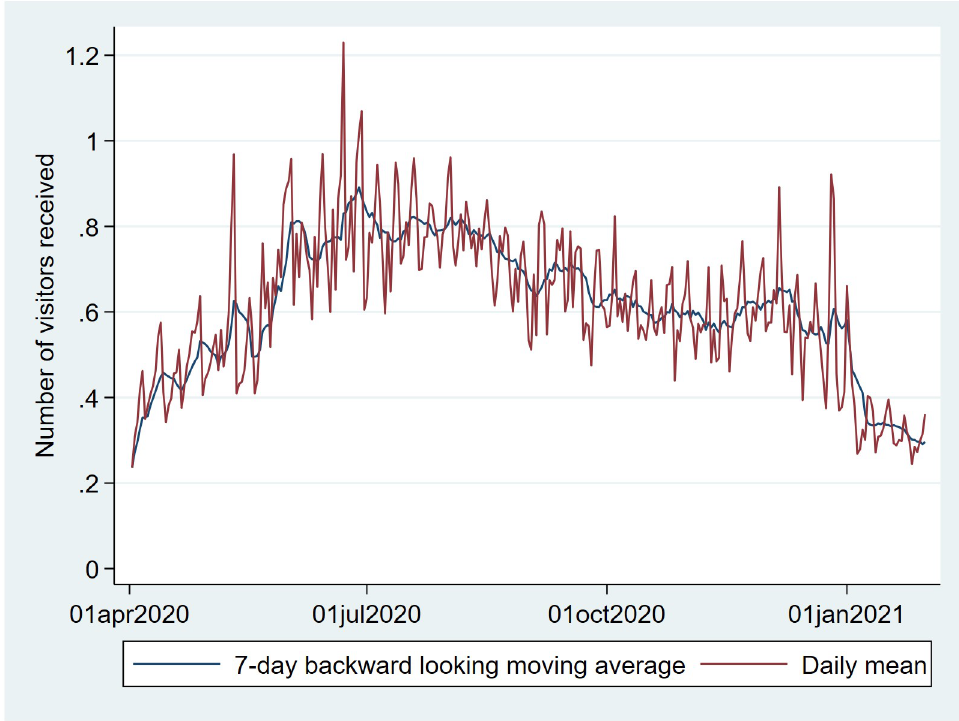
Fig 12. Daily mean number of visitors vs. time (with 7-day backwards moving average). Peaks are seen during Christmas and New Year’s Eve. The fifth of December is a holiday in the Netherlands known as “Sinterklaasavond”.